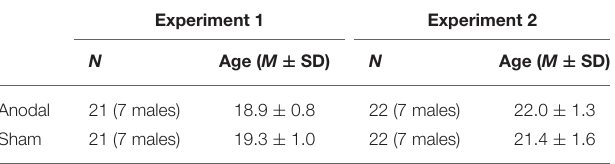
TABLE 1 | Demographic statistics for Experiments 1 and